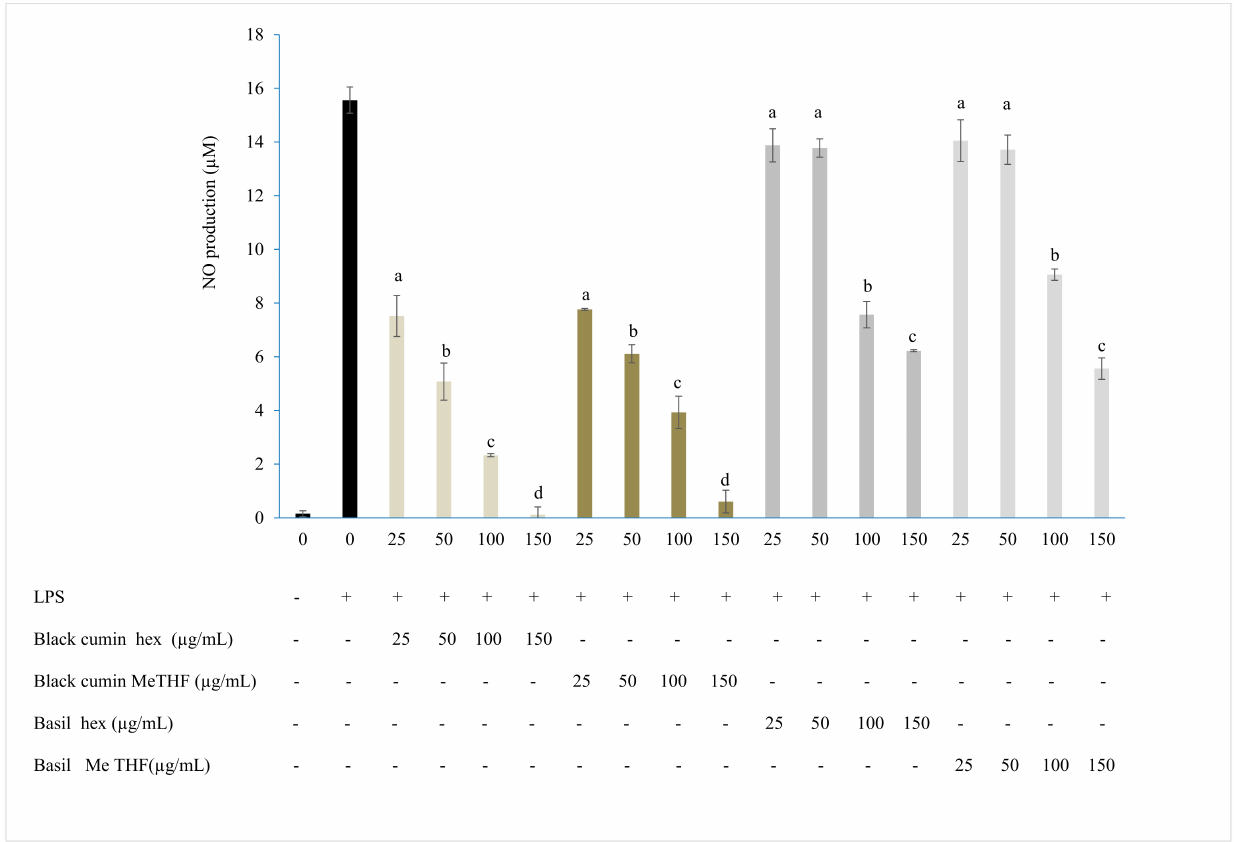
Figure 3. Effect of black cumin and basil oils obtained with conventional and green extractions on NO overproduction in LPS-stimulated RAW264.7 macrophages. The means with small letters (a–d) indicates significant differences between concentrations of solvent in the same species ( p <